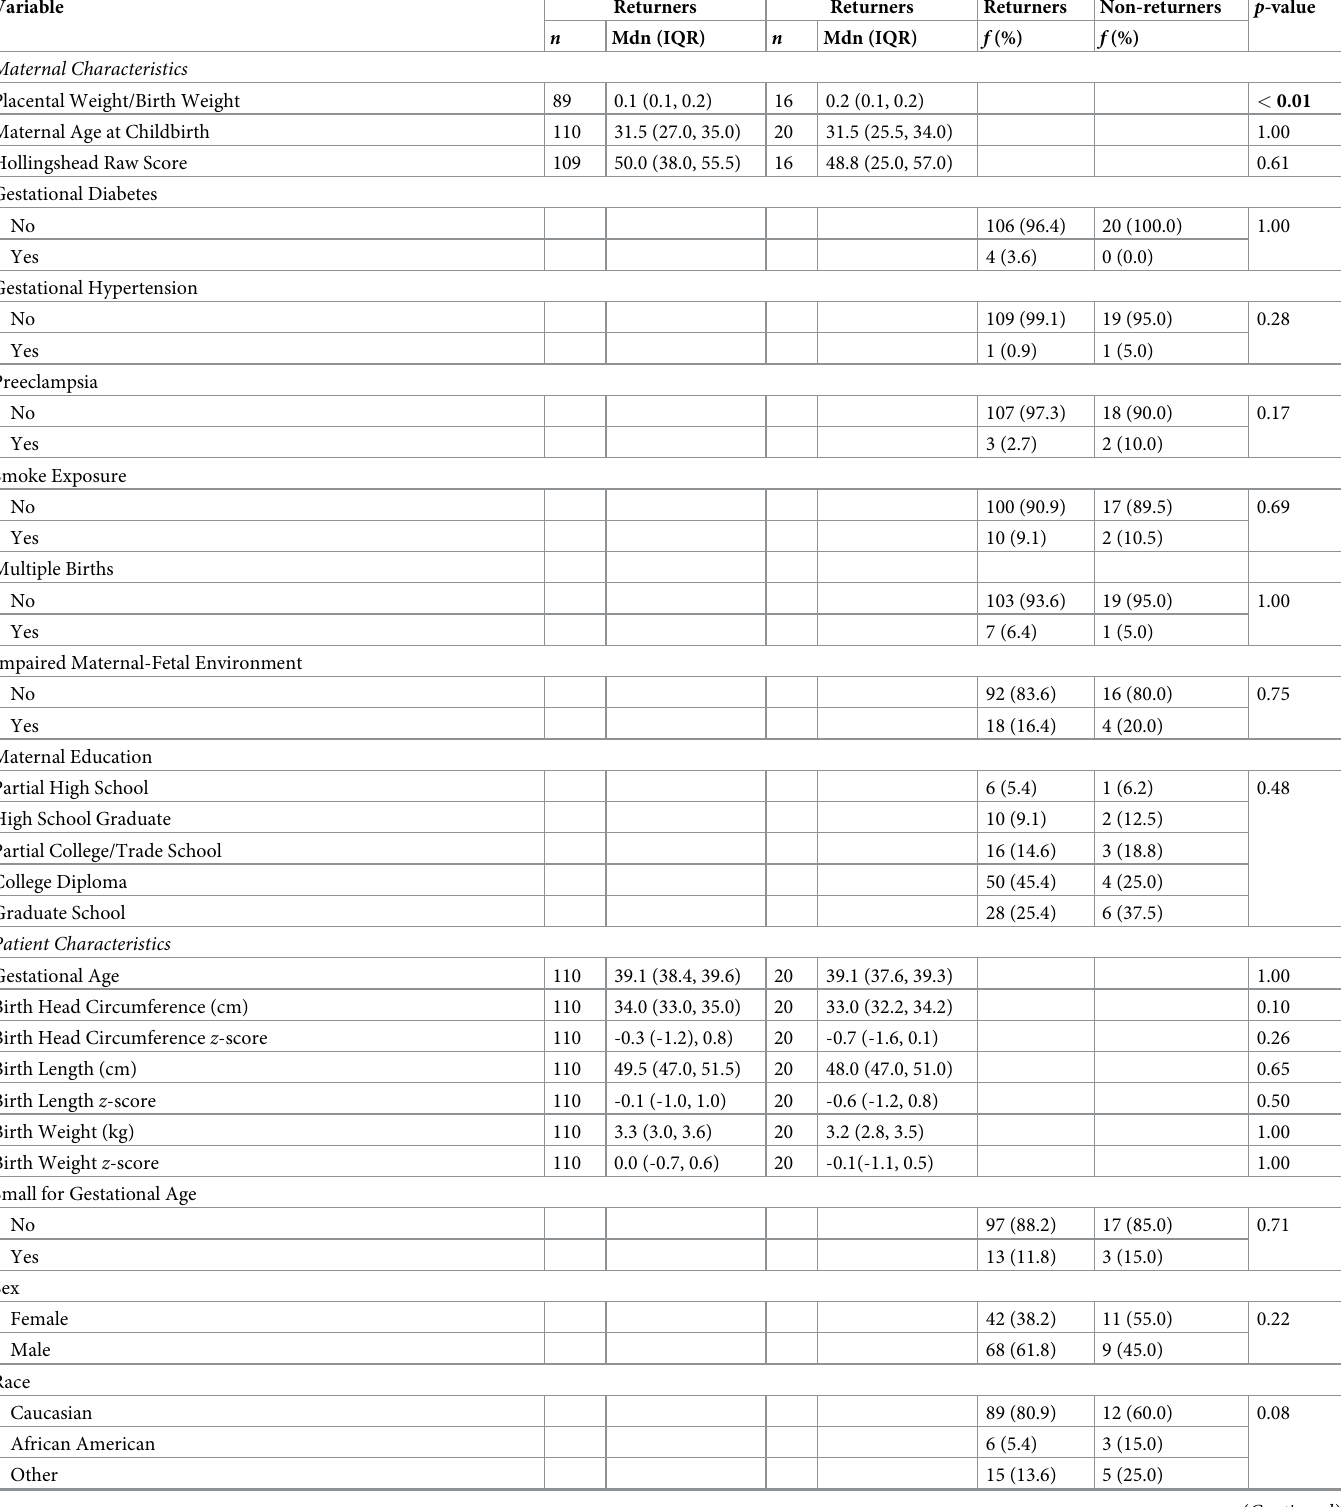
Table 2. Descriptive statistics and comparisons for returners (n = 110) vs. non-returners (N =